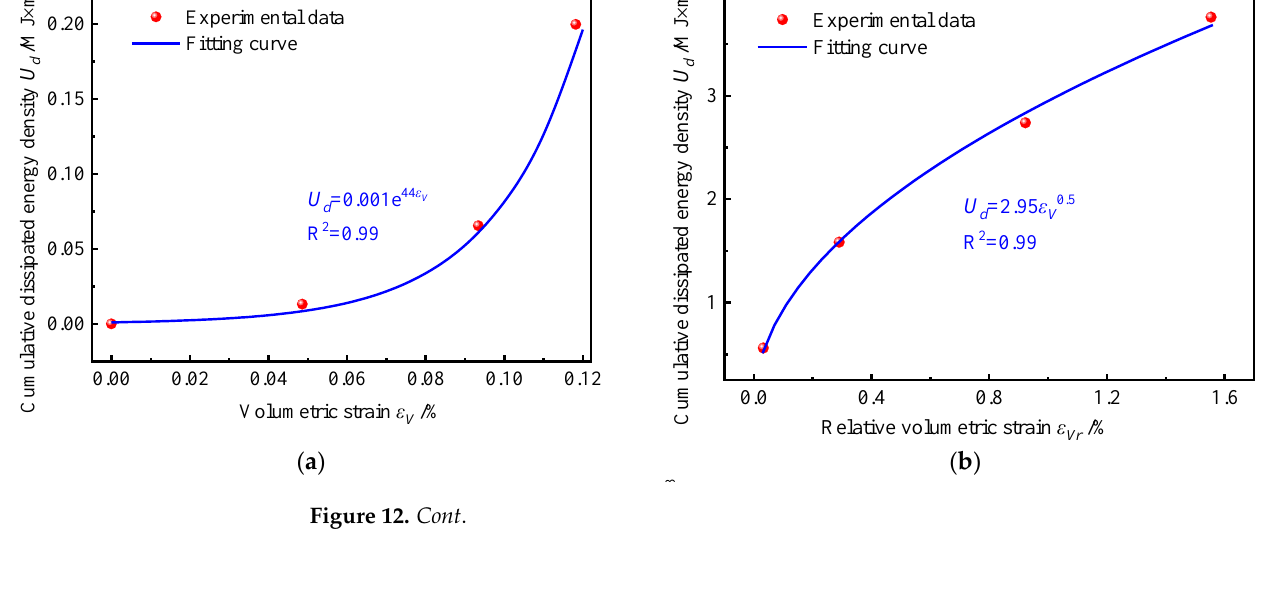
Figure 11. Diagram of the relative volumetric strain. The fitting result curves under different gas pressure p conditions of cumulative dissipated energy density U d with volumetric strain ε V in the compaction stage and relative volumetric strain ε r V in the dilation stage are shown in Figure 12.